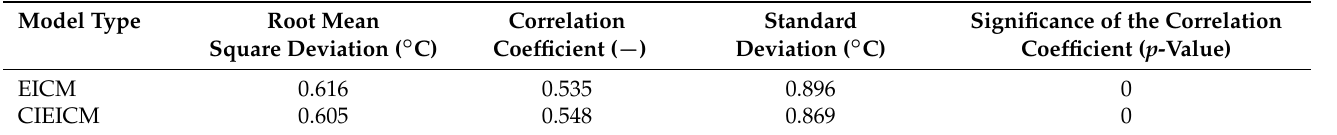
Table 2. Comparison of accuracy between EICM and CIEICM with OISST data.